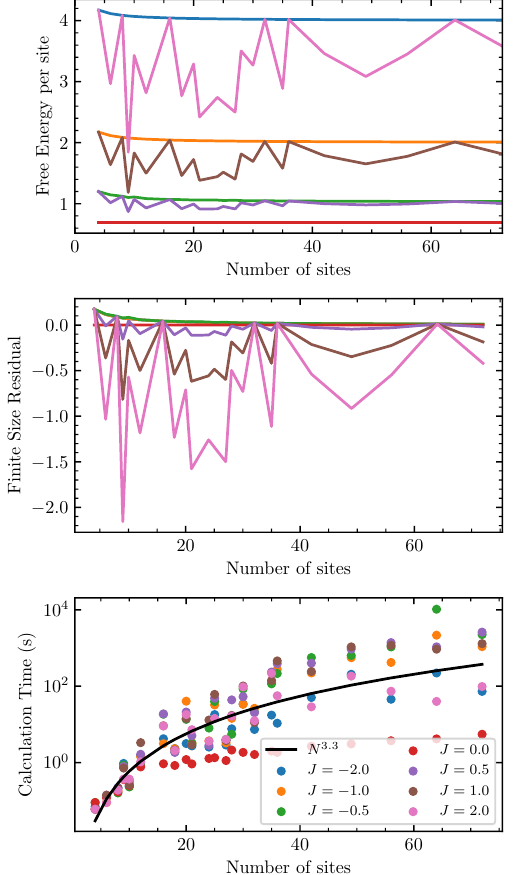
Figure 24: The free energy per site from PyTNR (top), residual versus the asymptotic value (middle) and computation time (bottom) for the 2D Ising model on a square lattice with periodic boundary conditions for h = 0 and several J is shown as a function of the number of sites N . The lattice dimensions were chosen to have aspect ratios no greater than 3 and to cover a range of N without large